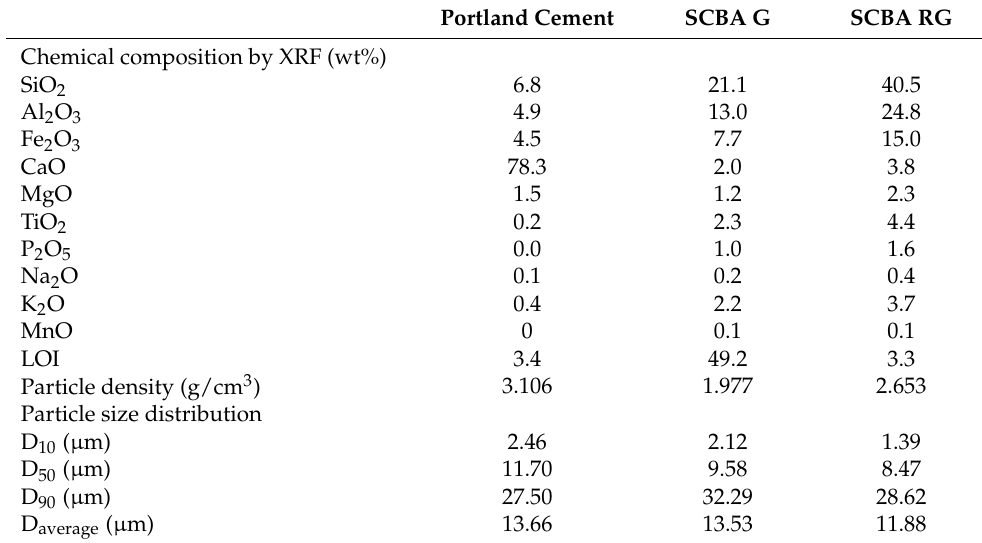
Table 2. Chemical composition by XRF, particle density, and particle size distribution of the samples.